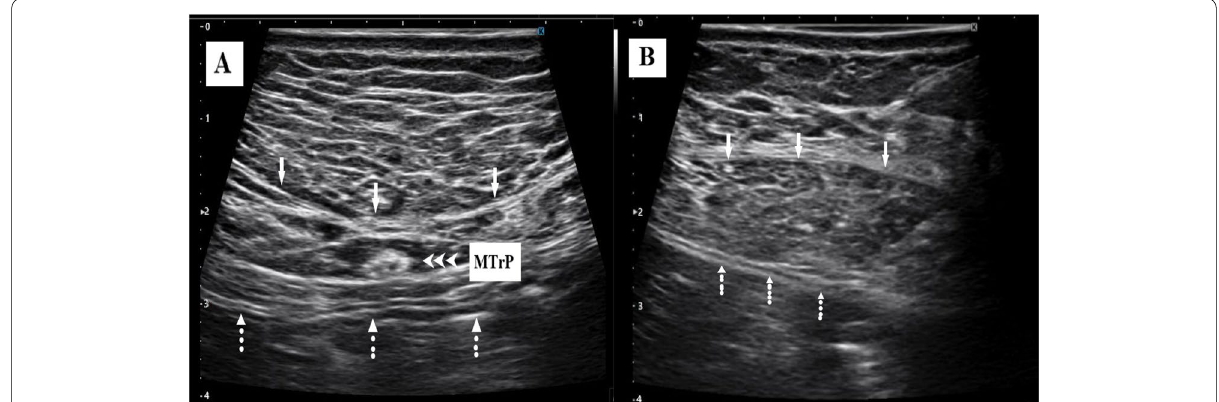
Fig. 1 Ultrasound image of the internal oblique abdominal muscle at the second ( A ) and the fifth visit ( B ). A spherical hyperechoic spot with a major axis diameter of 5 mm surrounded by a hypoechoic area is shown at the myofascial trigger point in the internal oblique abdominal muscle ( A ). The hyper- and hypoechoic area disappeared, which changed to an irregular muscle bundle alignment at the same site of A and its vicinity ( B ). Vertical arrows indicate the outer fascia of the internal oblique abdominal muscle, and dotted arrows indicate the peritoneum. MTrP, myofascial trigger